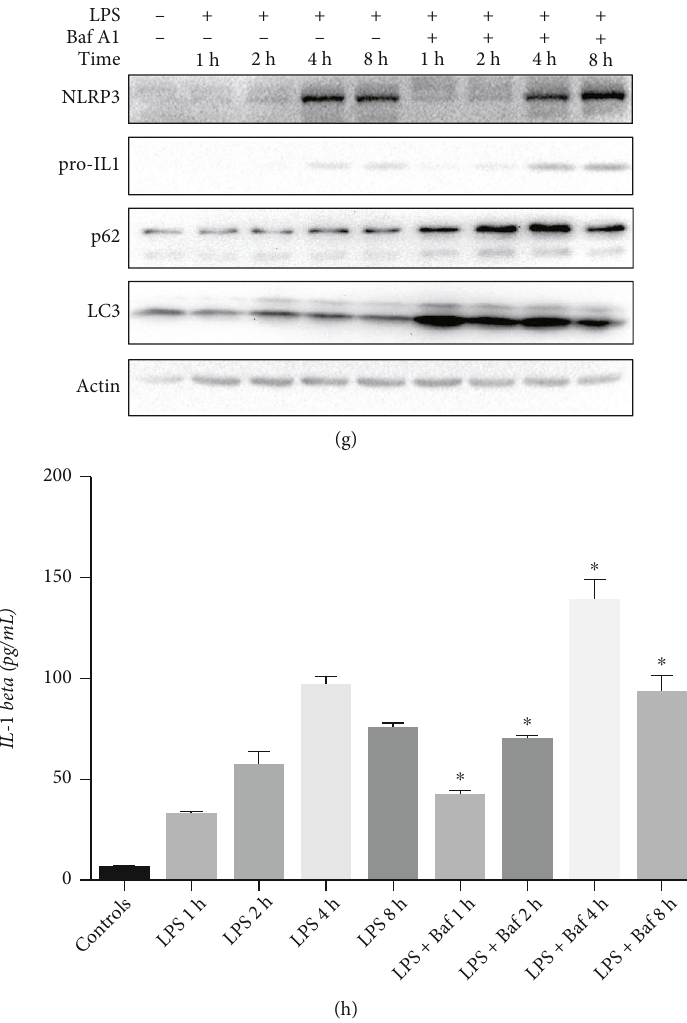
Figure 4: LPS inhibits autophagy via p38 MAPK in HSCs. (a, b) LX-2 cells in the logarithmic growth phase were treated with di ff erent concentrations of LPS (0-10 μ g/mL) for 4h. (c, d) LX-2 cells in the logarithmic growth phase were treated with 1 μ g/mL LPS in a time- dependent manner (0-12h). (e, f) LX-2 cells in the logarithmic growth phase were treated with 1 μ g/mL LPS together with or without 50nM rapamycin or 20 μ M SB203580 for 4h for the detection of autophagy. (g, h) LX-2 cells in the logarithmic growth phase were treated with 1 μ g/mL LPS together with or without 200nM Ba fi lomycin A in a time-dependent manner (0-8h) for the detection of